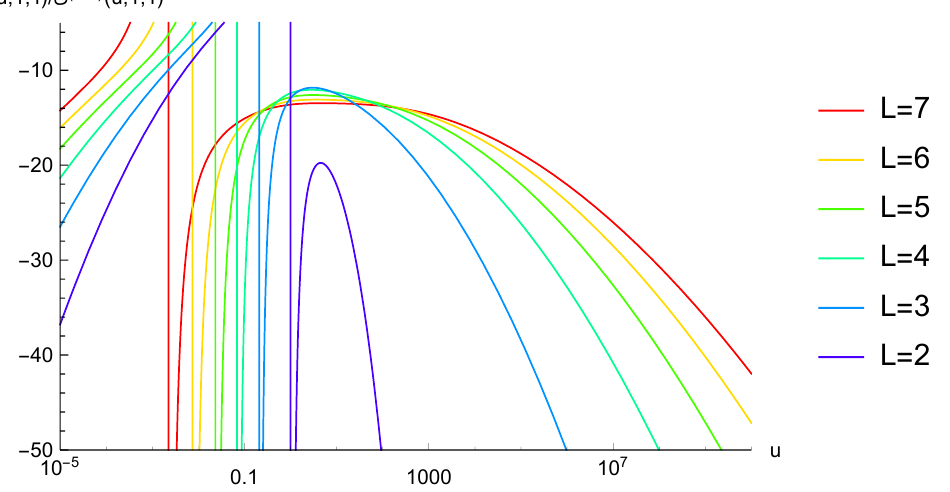
Figure 7 . E ( L ) ( u; 1 ; 1) = E ( L (cid:0) 1) ( u; 1 ; 1) evaluated at successive loop orders. As there are